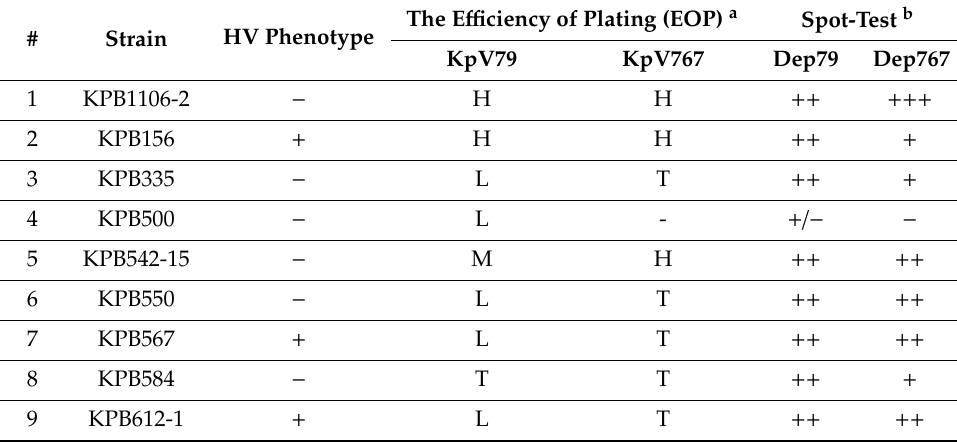
Table 2. The activity of bacteriophages KpV79 and KpV767 and their PS-depolymerases Dep79 and Dep767 against the K. pneumoniae strains of capsular type K57.